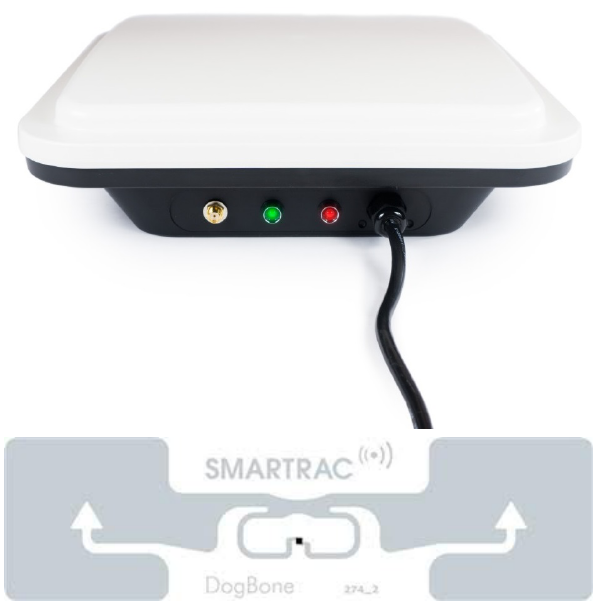
Figure 2. Ultra-high frequency (UHF) radio frequency identification (RFID) reader–antenna and passive RFID